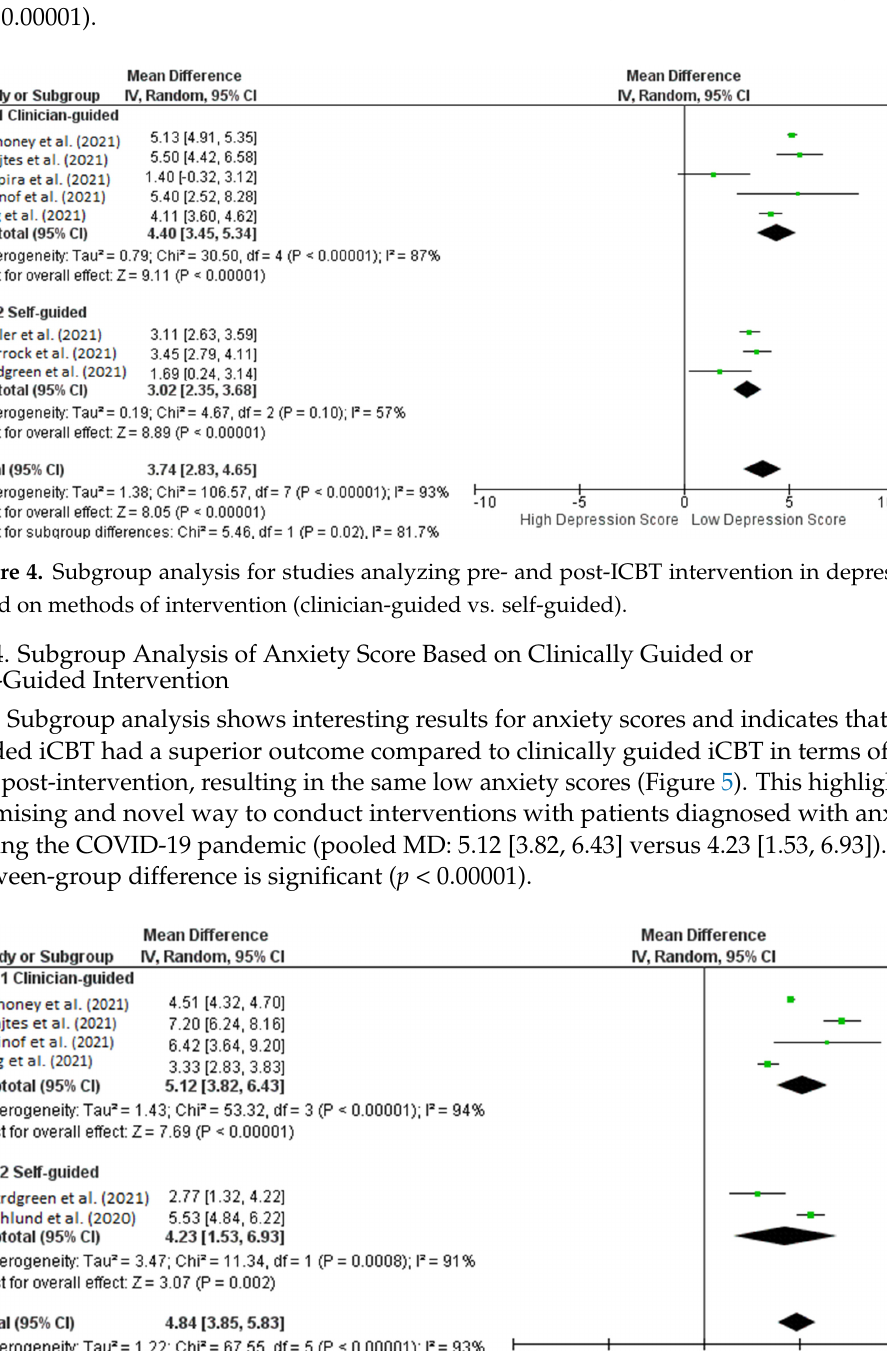
Figure 5. Subgroup analysis for studies analyzing pre- and post-ICBT intervention in anxiety based on methods of intervention (clinician-guided vs. self-guided).